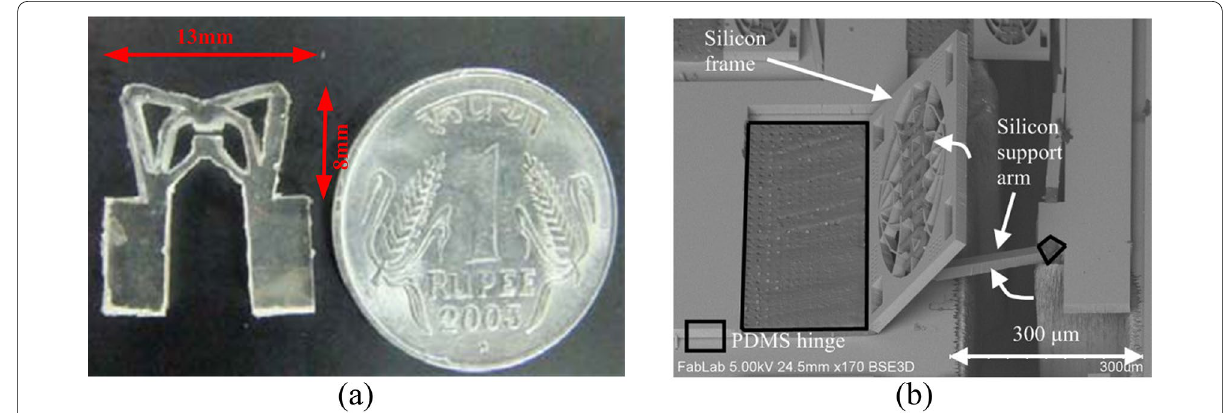
Figure 7 CMMs fabricated from PDMS: ( a ) Microgripper by Maheshwari et al. [84], ( b ) A silicon-PDMS hybrid out-of-plane mechanism with PDMS hinge by Gerratt et al. [4], (©IEEE. Adapted by permission of IEEE. Permission to reuse must be obtained from the